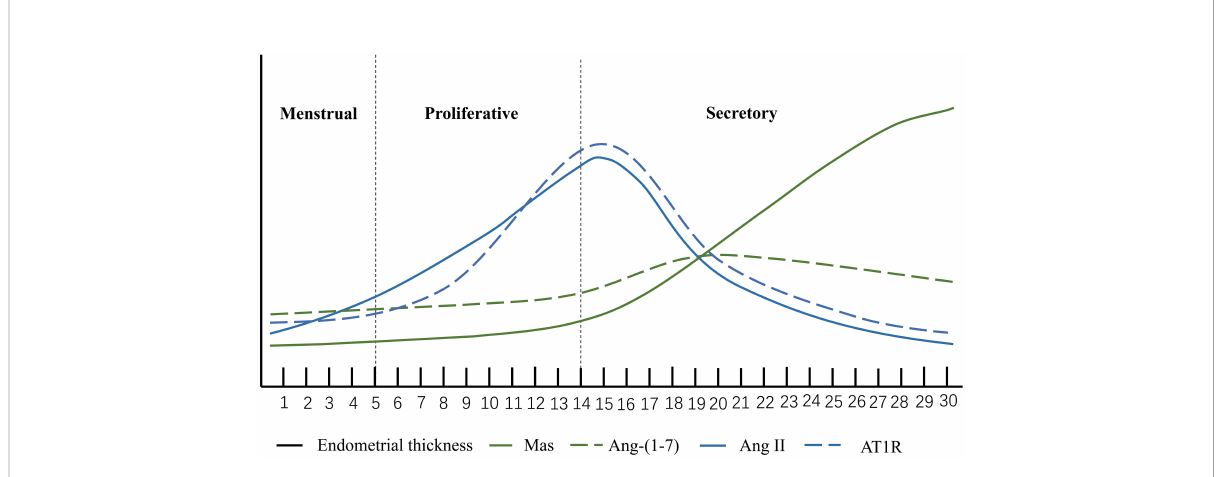
FIGURE 2 Ang II, Ang-(1-7), AT1R and Mas. The horizontal axis represents the menstrual cycle. The height of the vertical coordinate. The expression level of the molecule at each stage of the menstrual